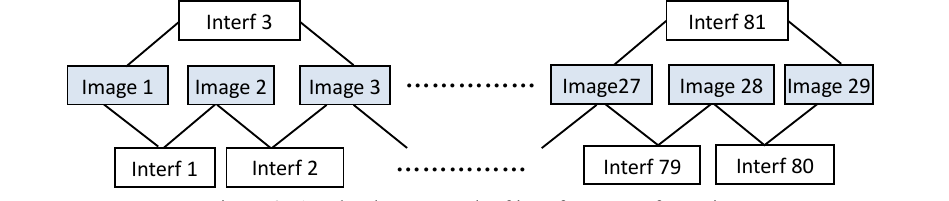
Figure 3: A redundant network of interferograms formation